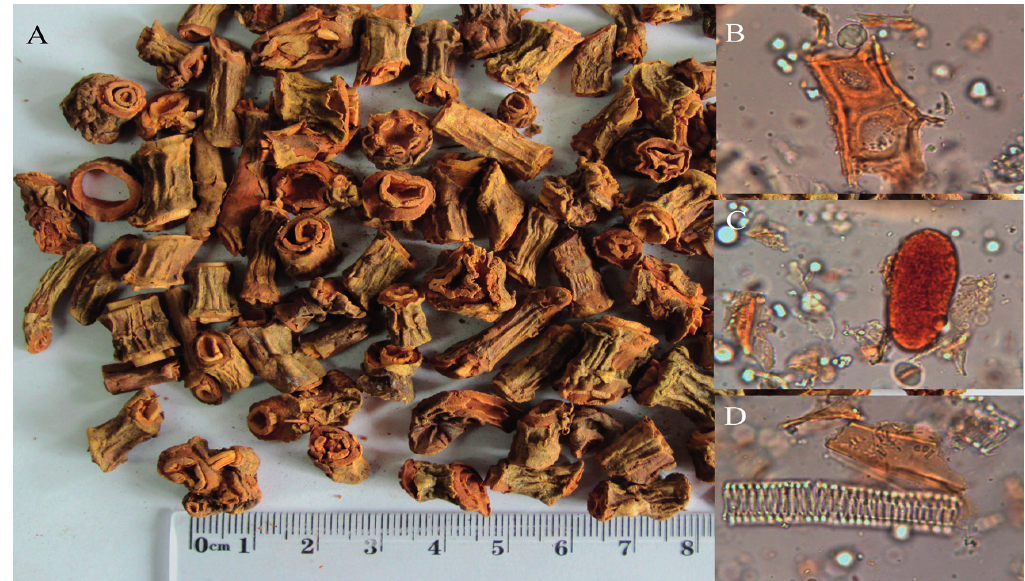
micrographs. ( A ) C. longgangensis var. hongyao medicinal material; ( B ) sclerenchymatous cell; ( C ) eleocyte; ( D ) reticulate